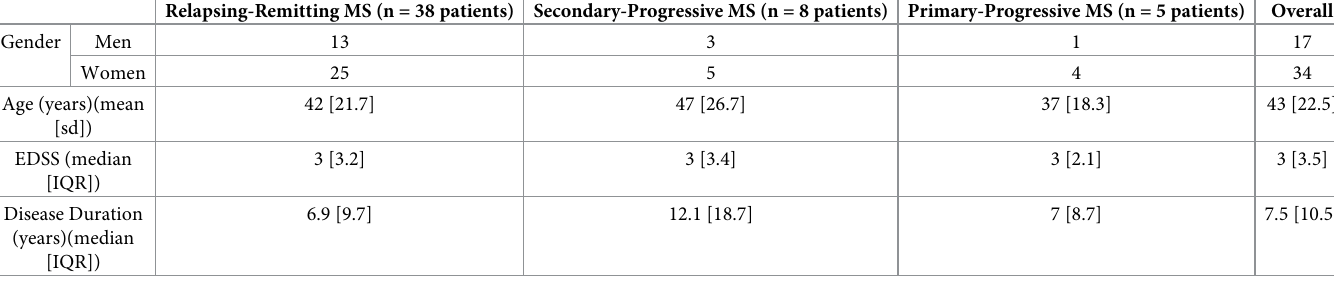
Table 2. Detailed demographic and clinical data of patients with Multiple Sclerosis